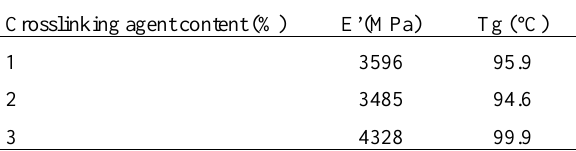
Table 1. Storage modulus (E’) and glass transition temperature (Tg) of polyHEMA with different crosslinking agent content measured by dy- namic mechanical